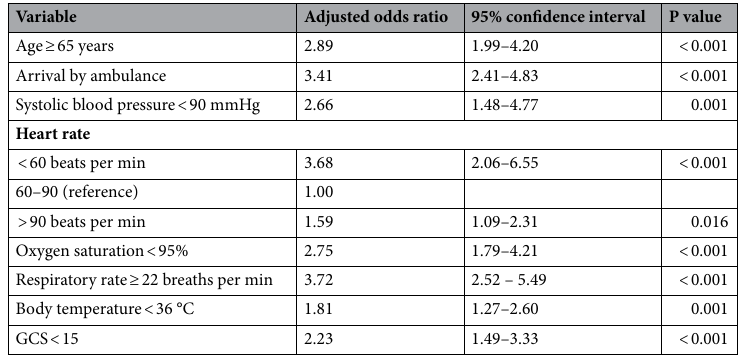
Table 2. Multivariable analysis of in-hospital cardiac arrest using emergency department in-hospital cardiac arrest score (EDICAS) as predictors. GCS Glasgow coma scale.